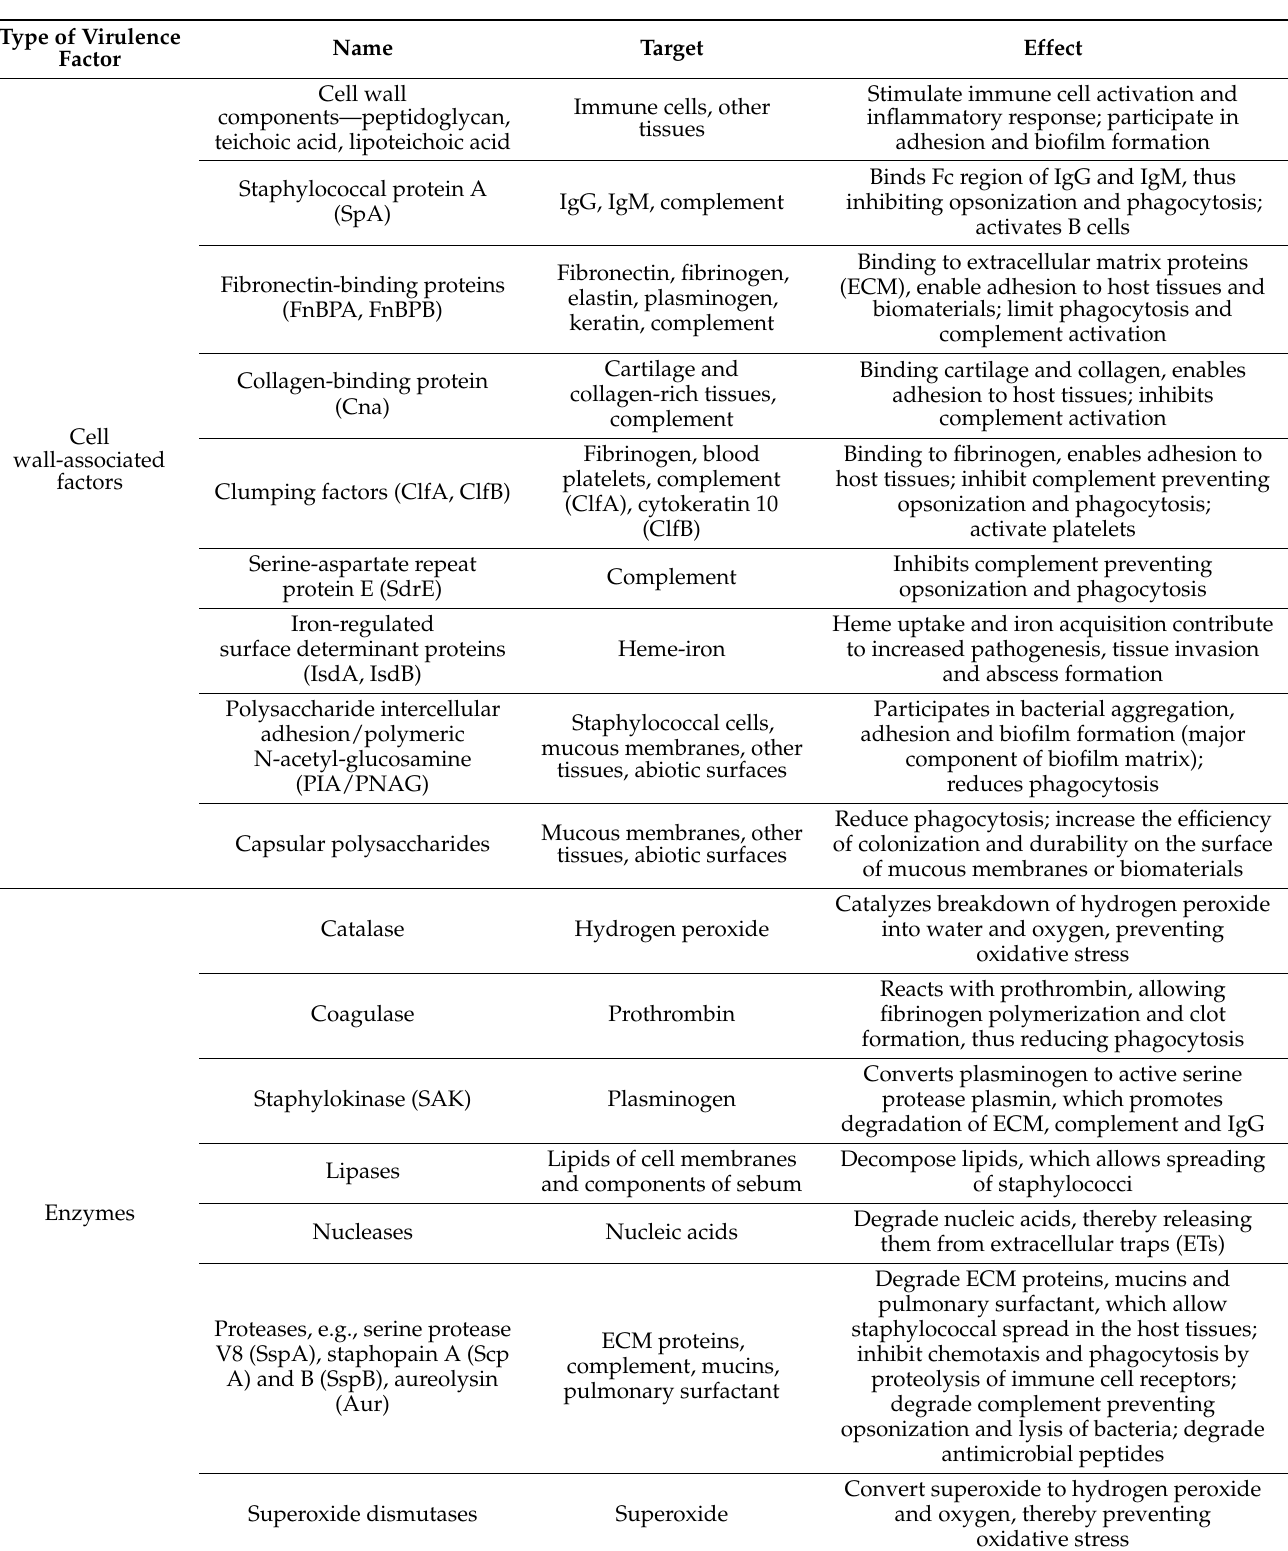
Table 1. The most important virulence factors of S. aureus and their targets during infection